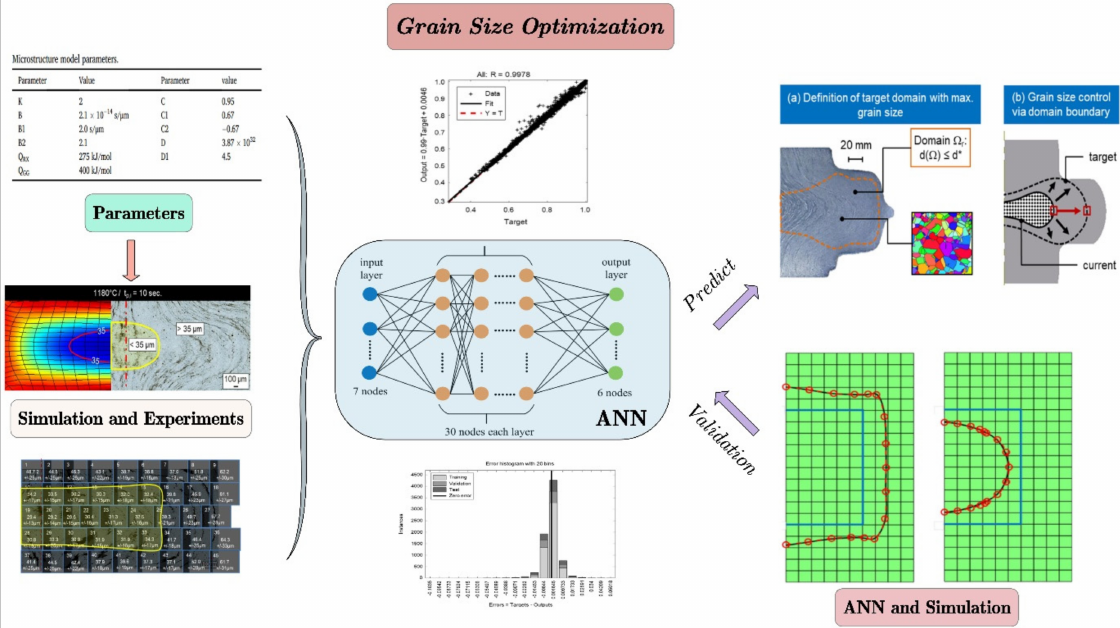
Figure 6. Property control in multi-stage hot forming based on machine learning [19].